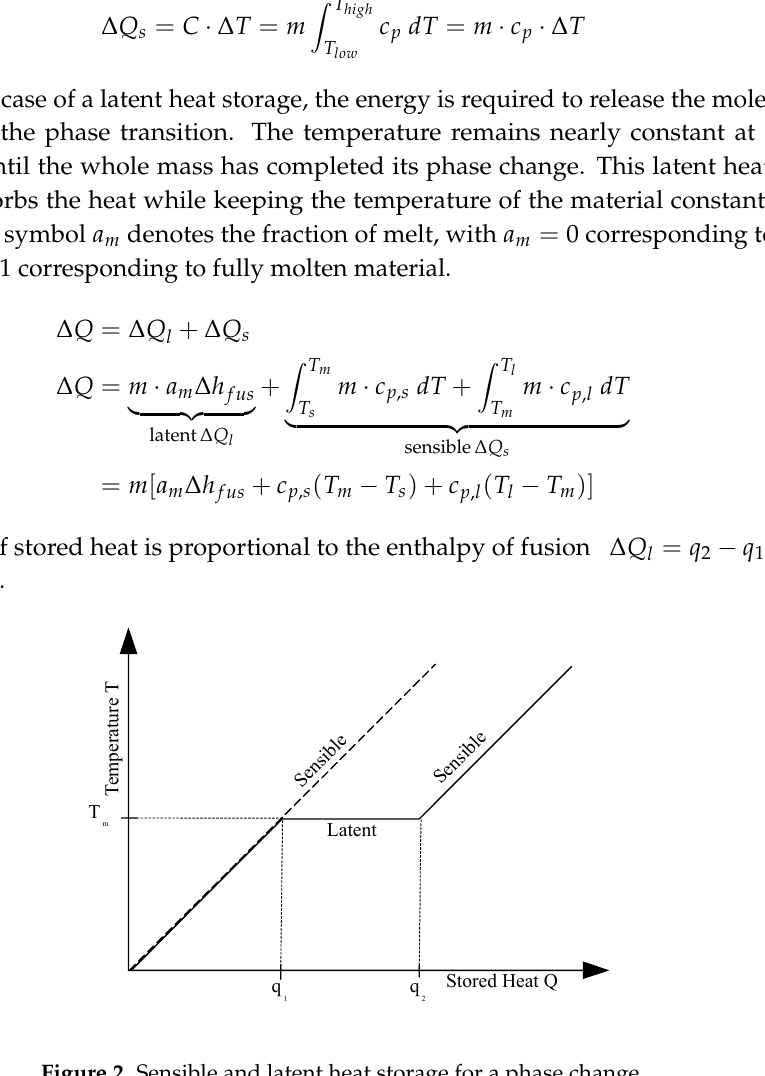
Figure 2. Sensible and latent heat storage for a phase